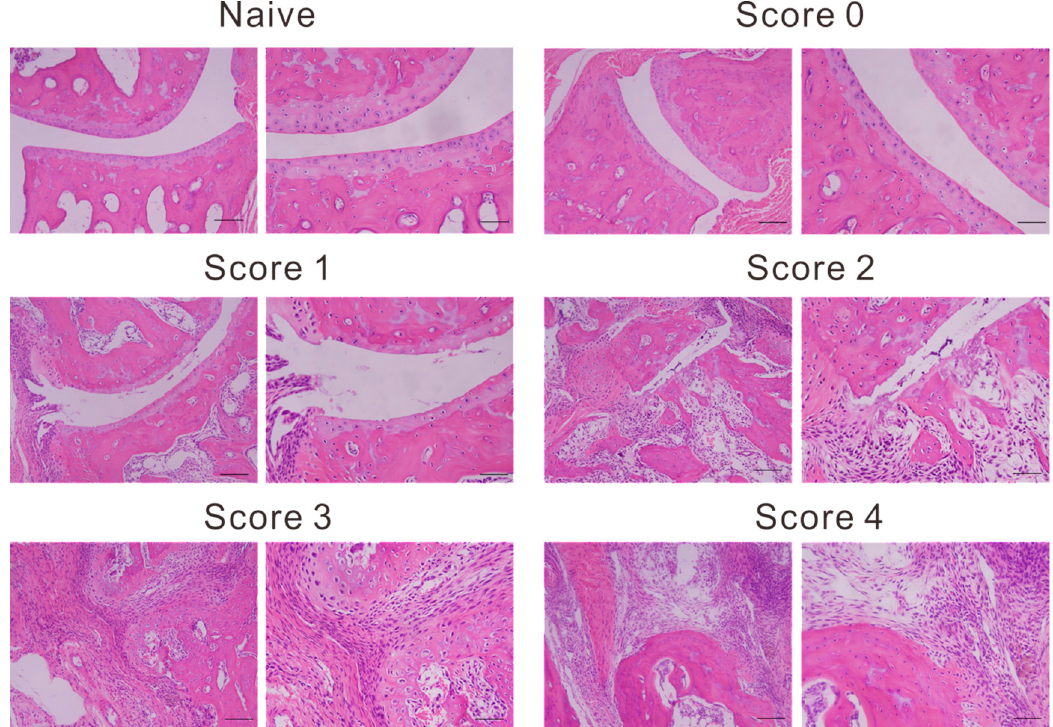
Figure 4. Representative images of histopathology sections. Naive and arthritic joint from each group, stained with hematoxylin and eosin (left panel magnification, ×100; right panel magnification, ×200). Photomicrographs of left hind ankles from five representative mice are shown for each clinical score group.